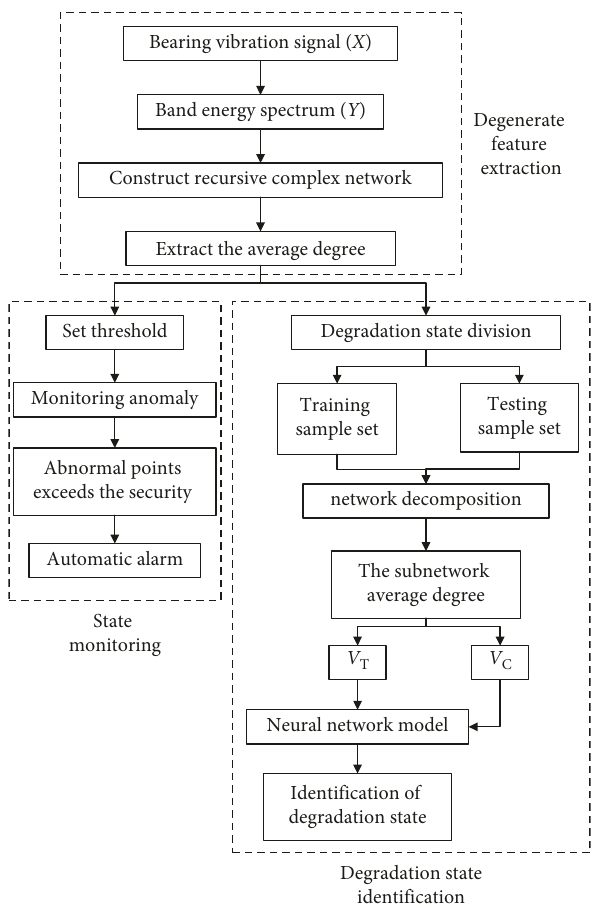
Figure 3: Flowchart for performance degradation assessment based on structural features from frequency complex